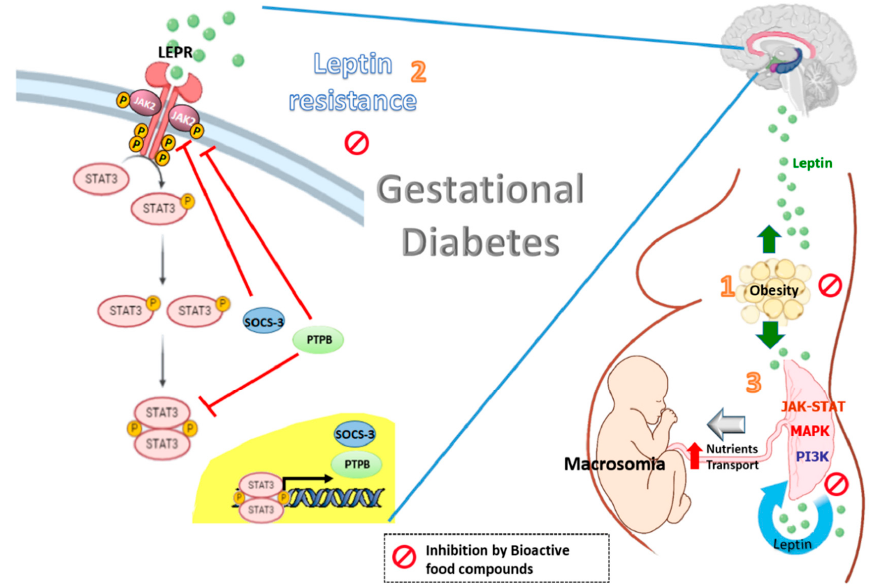
Figure 1. Effects of bioactive food compounds on the leptin resistance associated with obesity and gestational diabetes.